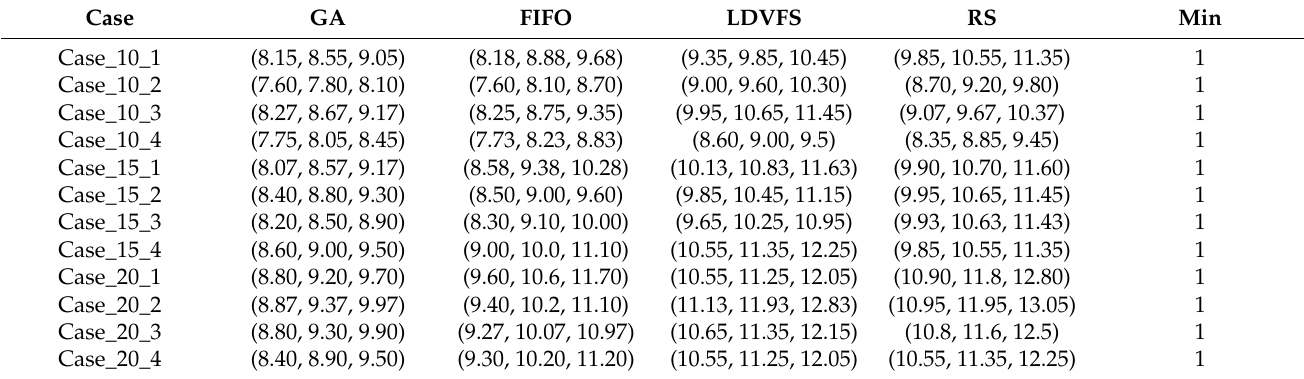
Table 7. Comparison of the results of different methods under different problem scales.